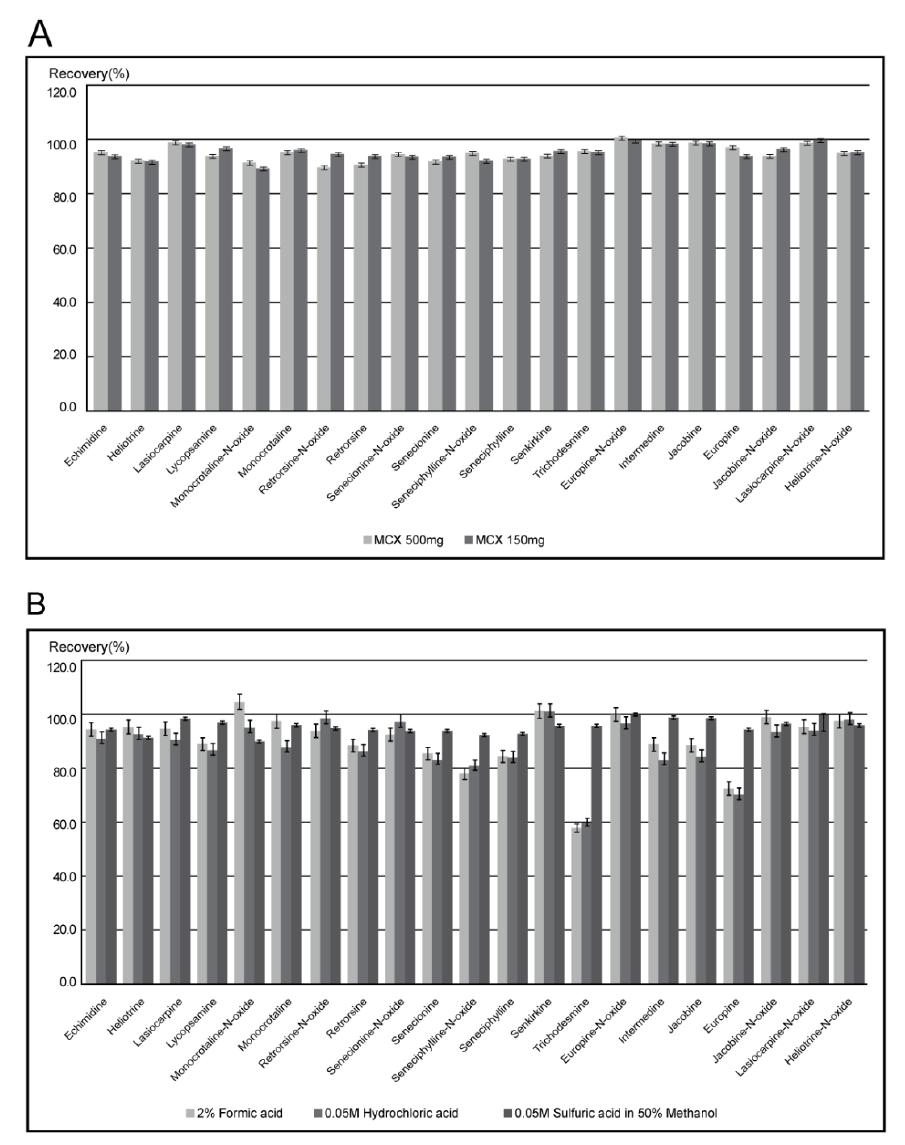
Figure 1. Recovery rates of PAs in tea (chrysanthemum) depending on ( A ) cartridge and ( B ) extraction solvent.